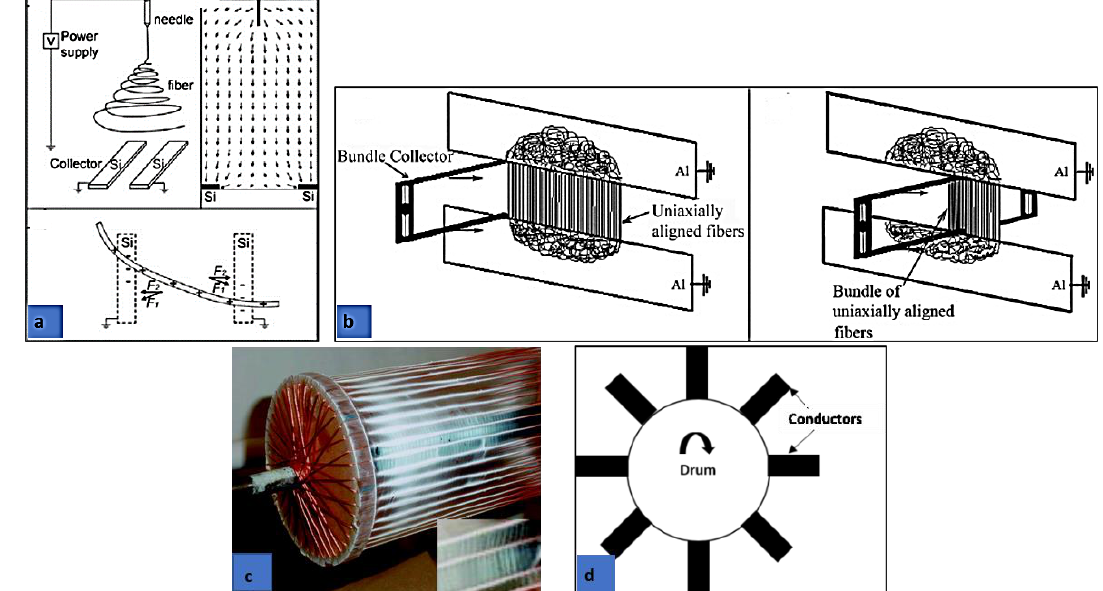
Figure 6. ( a ) Parallel conductor stripes method (reprinted with permission from Reference [128]. Copyright (2003) American Chemical Society). ( b ) Uniaxially aligned nanofibers [129]. ( c ) Wire drum collector (reprinted with permission